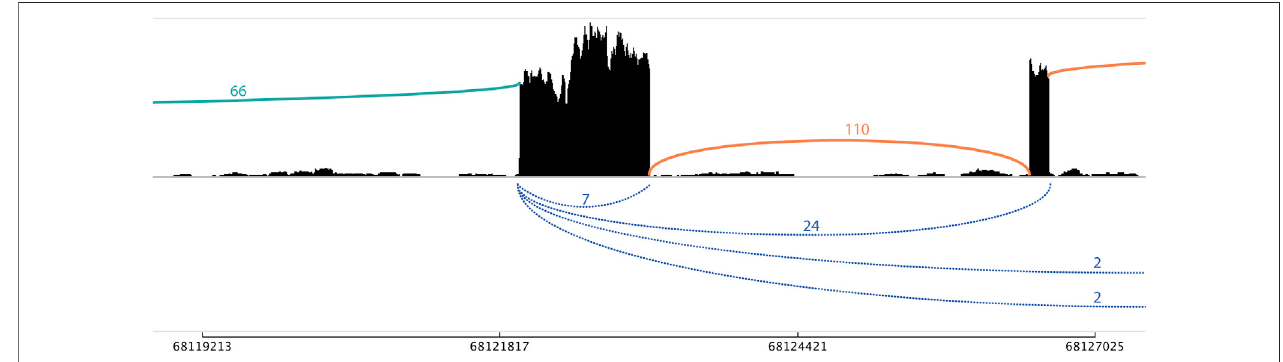
FIGURE 2 | Sashimi plot with linear only and ambiguous fl anking junctions of NFATC3 in HLF cells. A single-exon circRNA (chr16_68121986_68123121_+) has seven supporting back-splice reads (blue). The 66 forward-splice junction reads on the left do not fall within other detected back-splice junctions and are therefore classi fi edaslinearonly(green).The110forward-splicejunctionontherightareambiguous(orange)ascanbederivedfrombothlinearandcirculartranscripts[with24,2, and 2 back-splice reads supporting the back-splice junctions that span these forward-splice junctions, respectively (blue)].